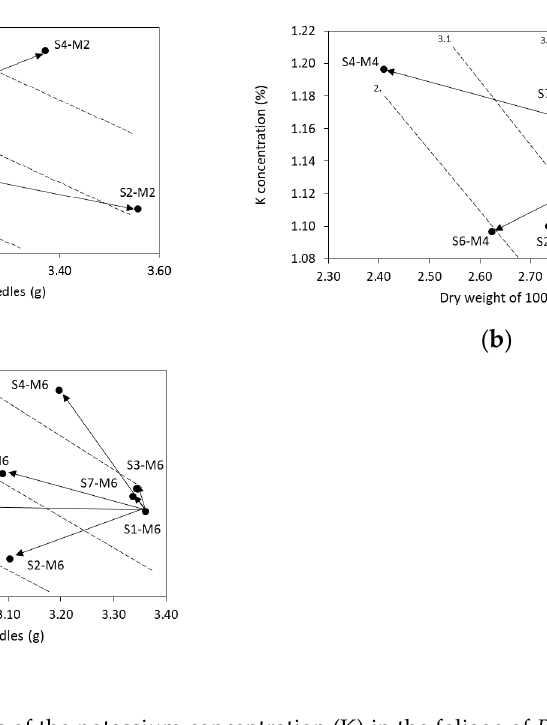
Figure 6. Projected substrate cost in a production of 100,000 seedlings of Pinus engelmannii , produced in polystyrene containers with 77 cavities of 170 mL.